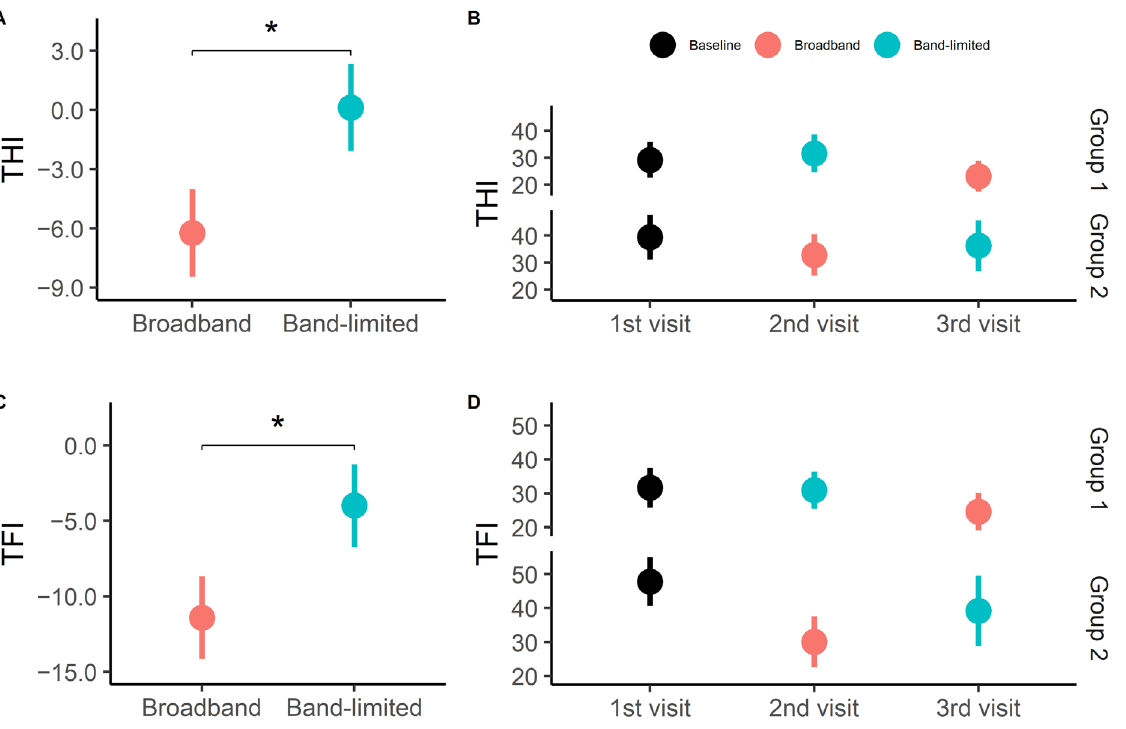
Figure 4. Tinnitus distress. ( A ) Average change in THI scores after broadband and band-limited amplification from baseline. The data from groups 1 and 2 were pooled for both the broadband and band-limited conditions. Averages are presented as mean ± SEM. * p < 0.05. ( B ) Average THI scores at each visit subdivided into treatment groups. ( C ) Average change in TFI scores after broadband and band-limited amplification from baseline. The data from group 1 and 2 were pooled for both the broadband and band-limited conditions. Averages are presented as mean ± SEM. * p < 0.05. ( D ) Average TFI scores at each visit subdivided into treatment groups.